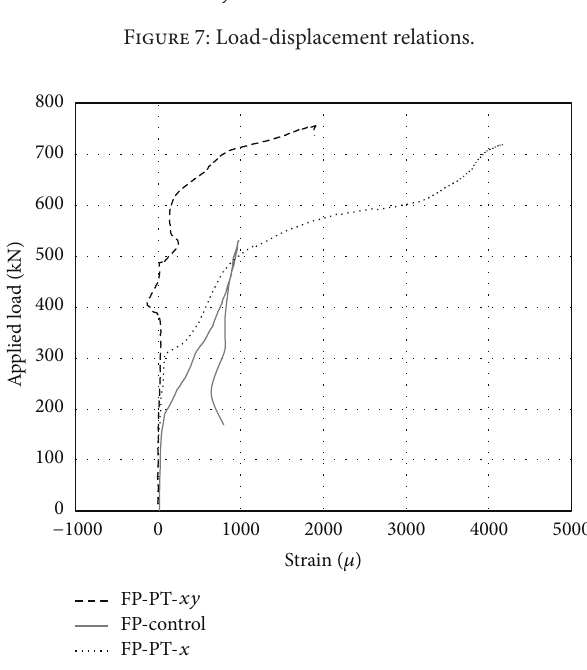
Figure 8: Load-strain relations.